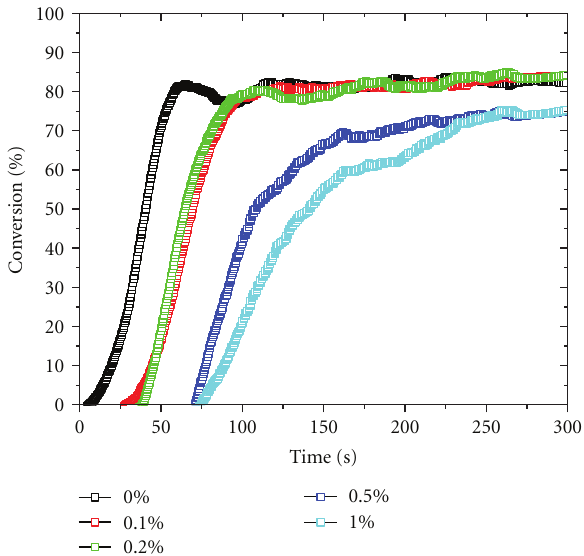
Figure 6: The conversion of monomer mixtures with di ff erent dye contents.